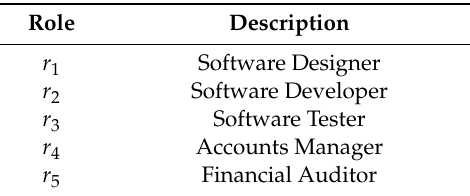
Table 9. Descriptions of roles.